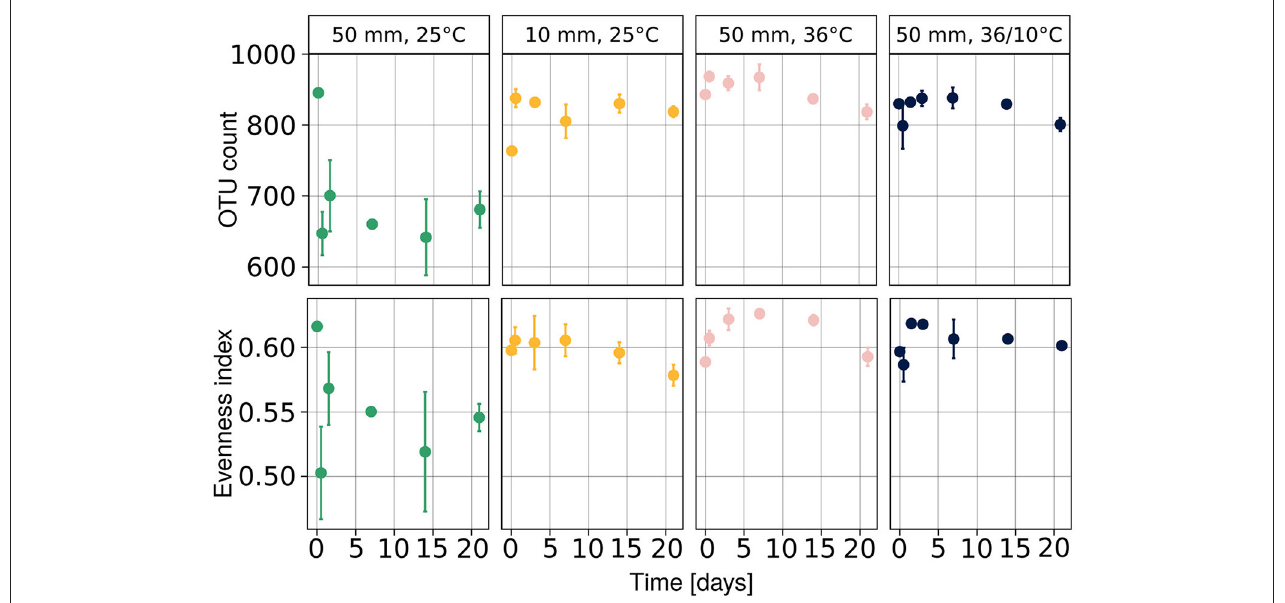
FIGURE 4 | Diversity of the bacterial community at each time point expressed as evenness and richness components. Population richness is expressed as number of observed species and evenness was evaluated with Pielou’s index. Average values are presented as mean ± SEM, based on three observations per data point. OTU, operational taxonomic